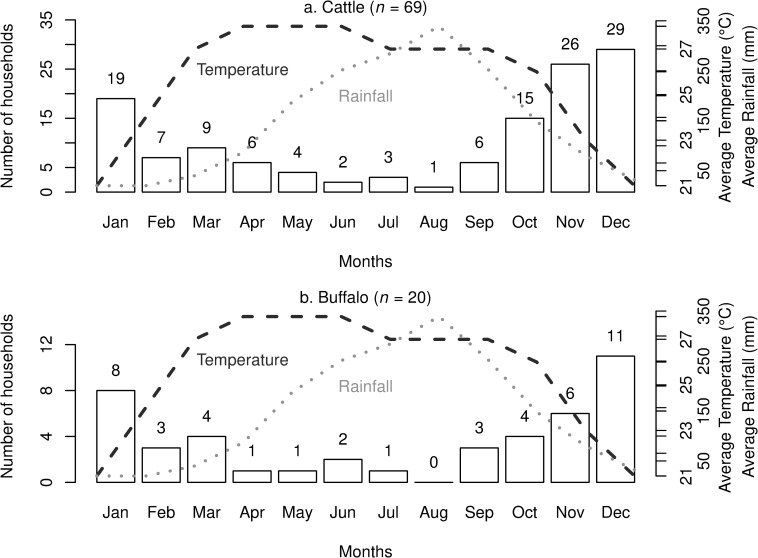
Histograms of the main calving months reported by smallholder farms in 2018, Lao PDR.(a) cattle calves (b) buffalo calves. Temperature data are from the Meteorological Organization Standard Normals 1961–1990 [44] and rainfall data from the Climate Change Knowledge Portal 1901–2015 [45].